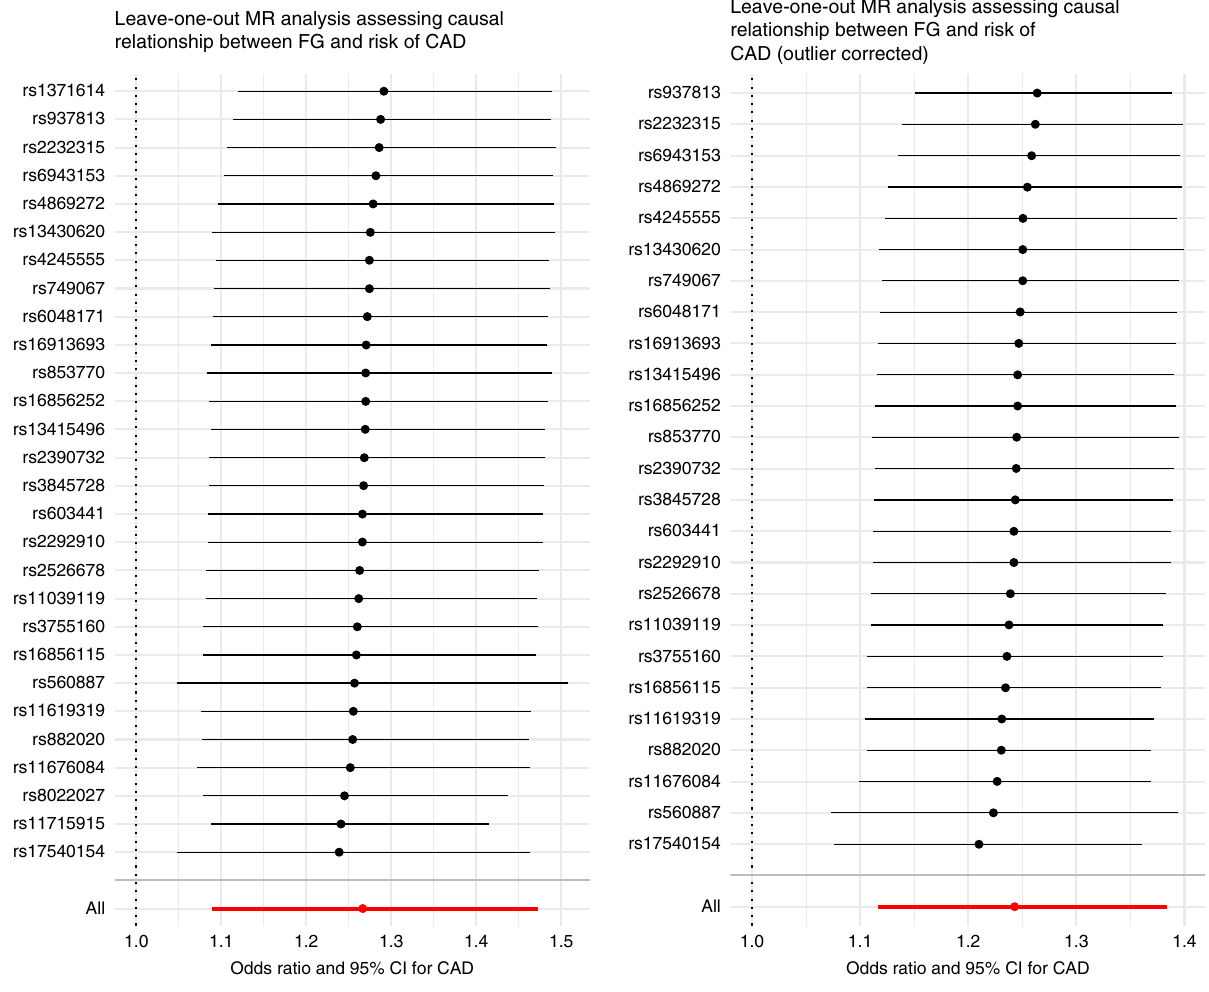
Fig. 5 Leave-one-out analysis plots of causal relationship between fasting glucose and CAD. Data are presented as odds (OR) ratio and 95% con fi dence interval (95% CI) of the exposure-outcome relationship for each SNP. Center points represent the causal effect estimate and the horizontal bars represent the respective 95% CI. Left panel represents data from all SNPs that passed QC ( n = 28) while right panel represents SNPs retained after correcting for outliers using MRPRESSO, n = 25 SNPs. Source data are provided as Source Data fi